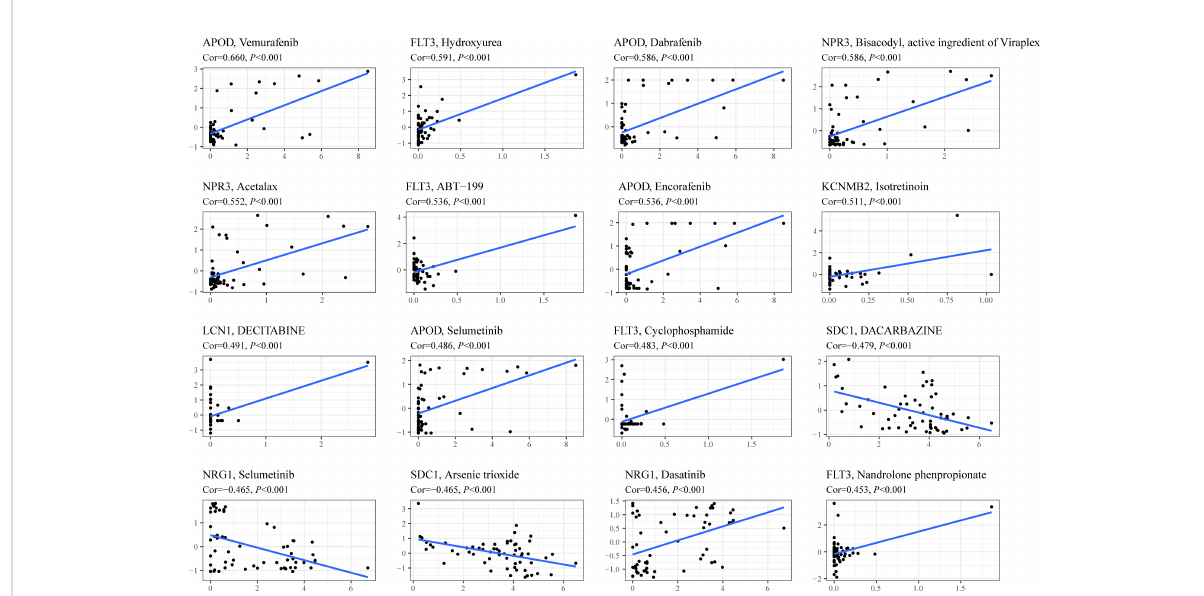
FIGURE 7 Drug sensitivity prediction based on TIIS. Scatter plots of correlation between gene expression (abscissa) and Z score of anti-tumor drugs calculated by Pearson correlation test (ordinate) based on the CellMiner database. Each black point represented an independent sample. The blue line was the linear regression